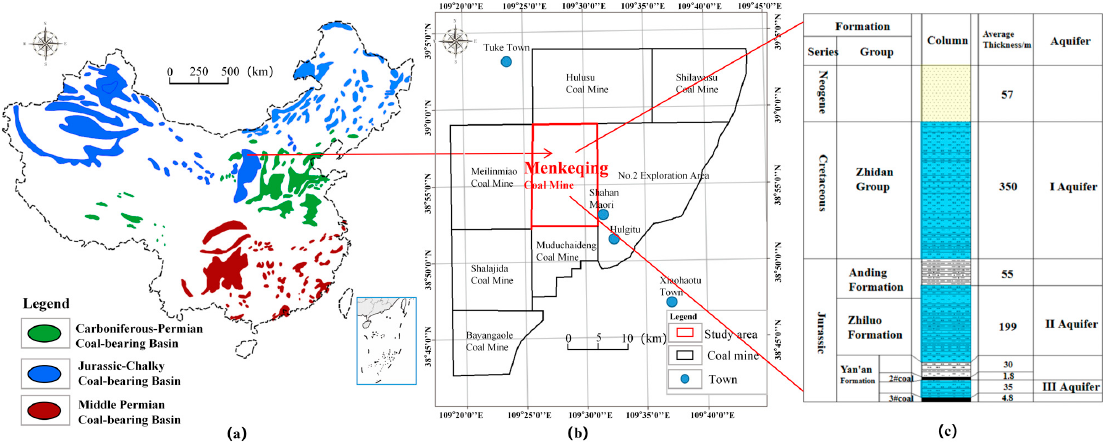
Figure 1. ( a ) Distribution of major coal resources in China; ( b ) location of Menkeqing Coal Mine; ( c ) stratigraphic histogram of Menkeqing Coal Mine.